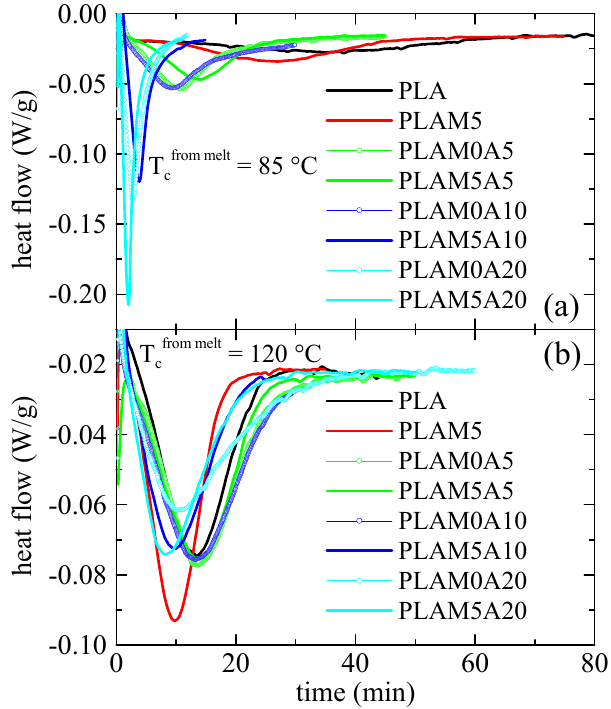
Figure 9. Crystallization isotherms (exo down) from the melt for the different samples at ( a ) T c = 85 °C, and ( b ) 120 °C.